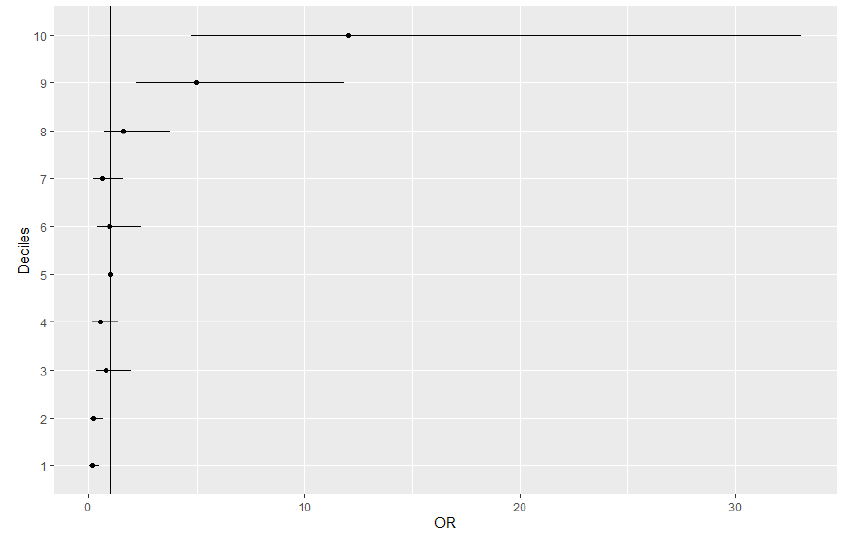
Figure 3. OR by decile of the multivariate model before imputation.